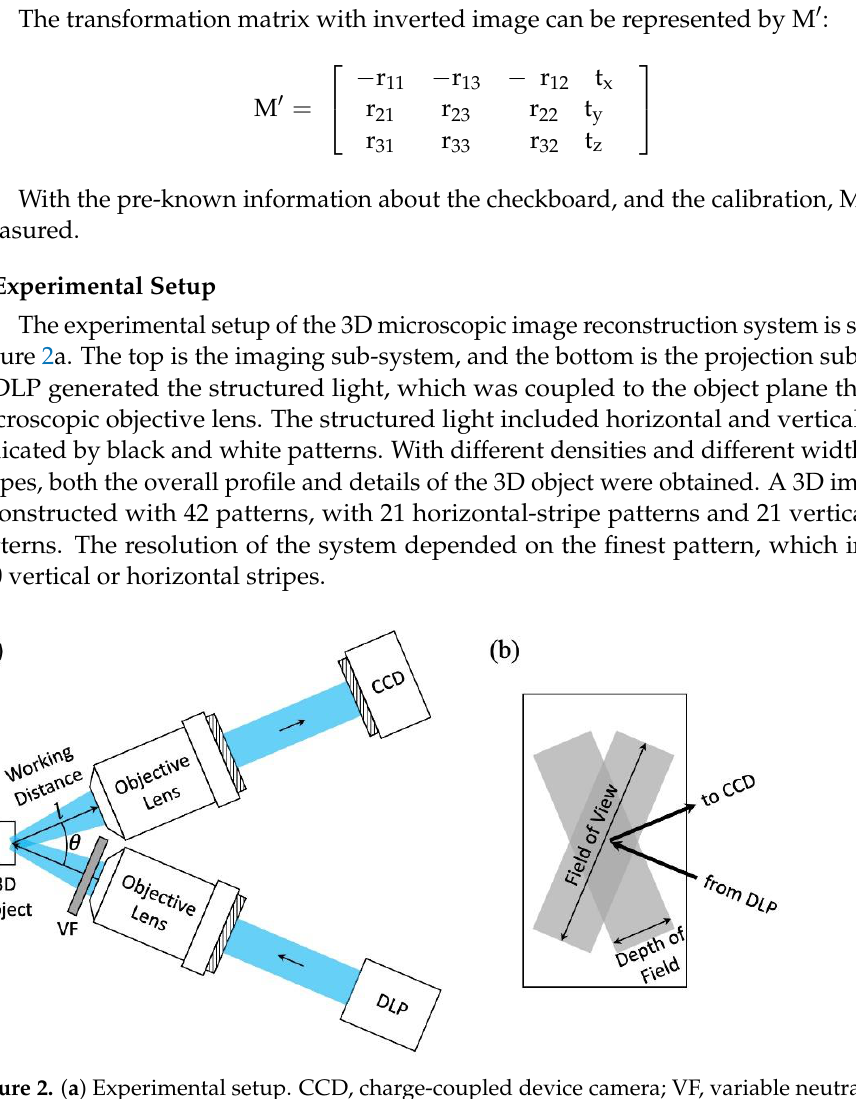
Figure 2. ( a ) Experimental setup. CCD, charge-coupled device camera; VF, variable neutral density filter; DLP, digital light processing projector. ( b ) Enlarged view of the rectangle region labeled with “3D object” in ( a ).